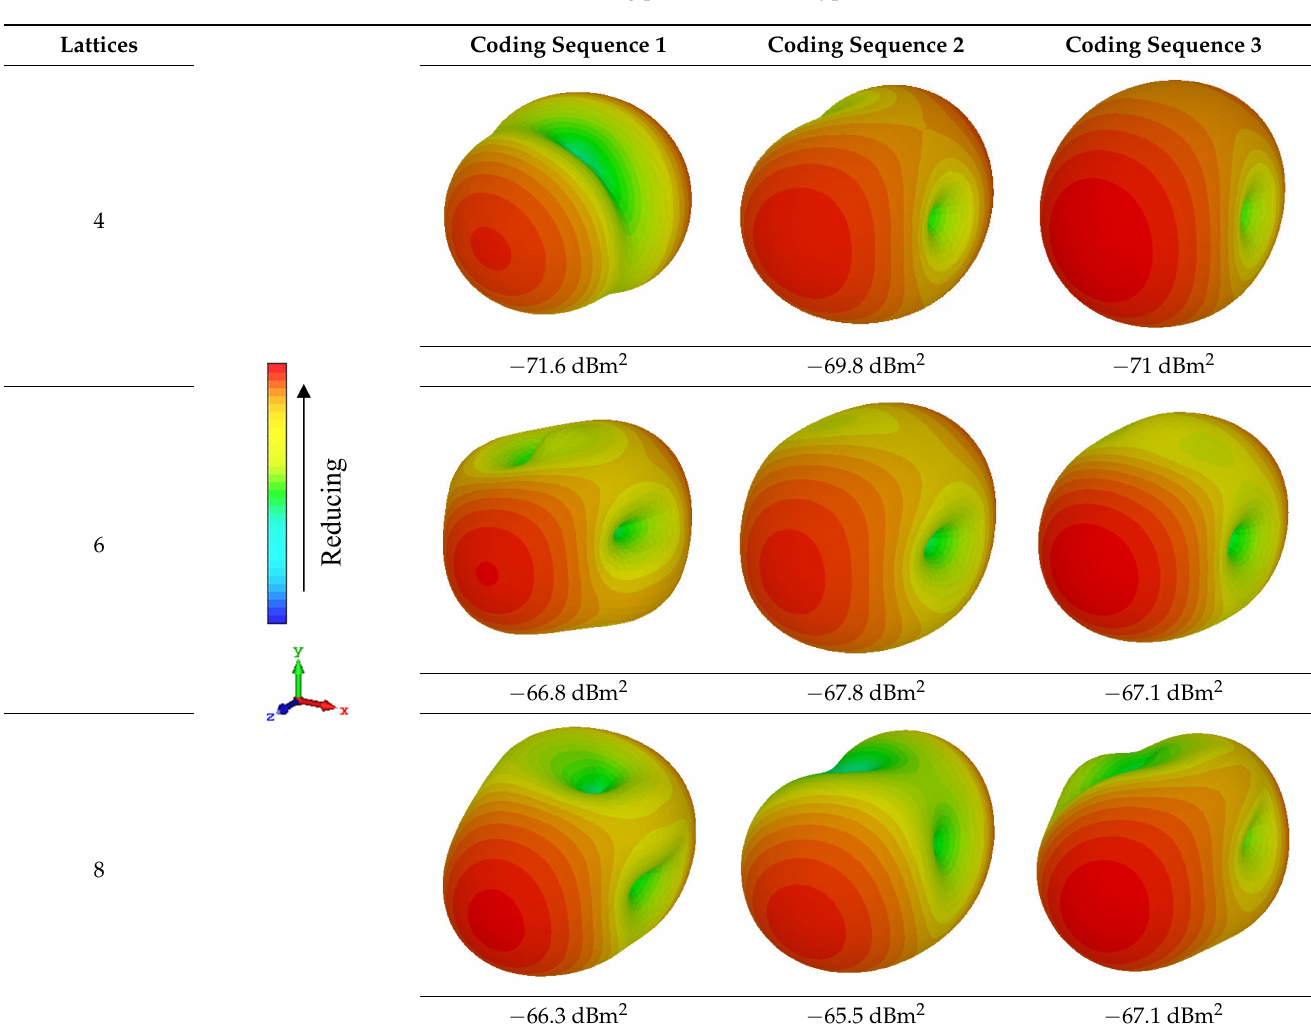
Table 4. Bistatic RCS scattering patterns of three types of smaller lattices at 1.54